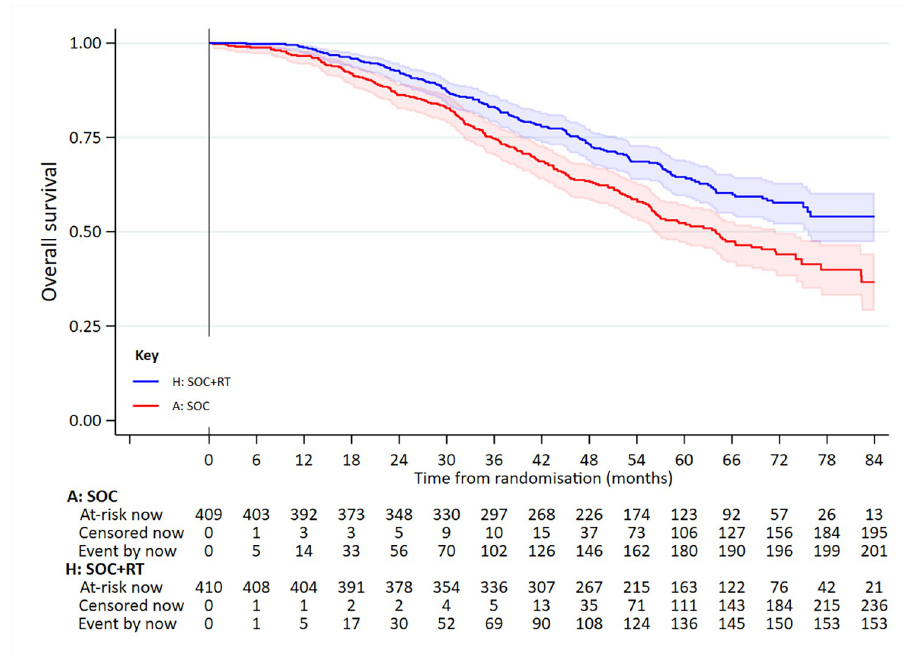
Fig 3. OS in patients in the low-burden metastatic disease group. Adjusted HR = 0.64 (95% CI 0.52 to 0.79; p < 0.001 [ p = 0.00004]). HR, hazard ratio; OS, overall survival; RT, radiotherapy to the prostate; SOC, standard of care.